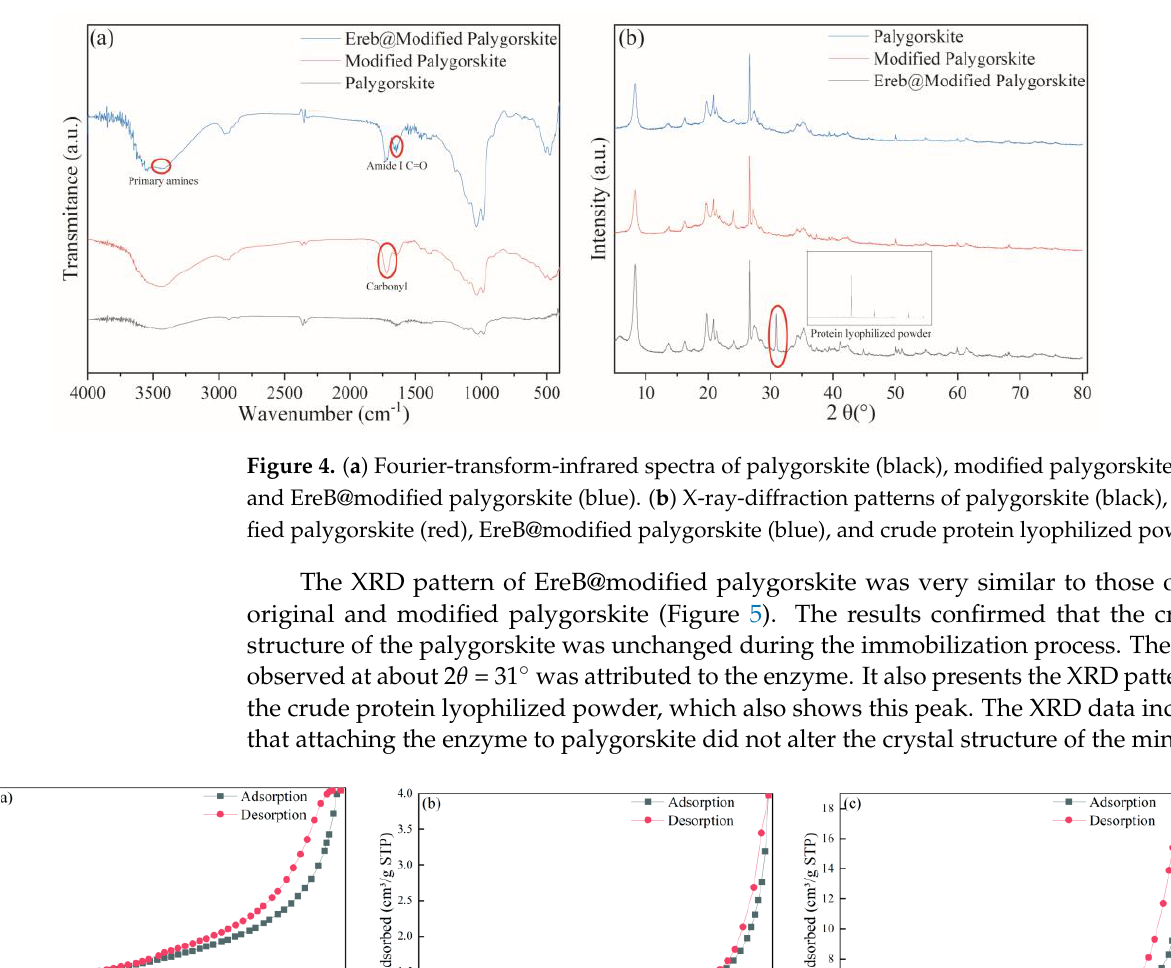
Figure 3. Scanning electron micrographs of: ( a ) palygorskite (10,000×), ( b ) modified palygorskite (10,000×), and ( c ) EreB@modified palygorskite (30,000×).